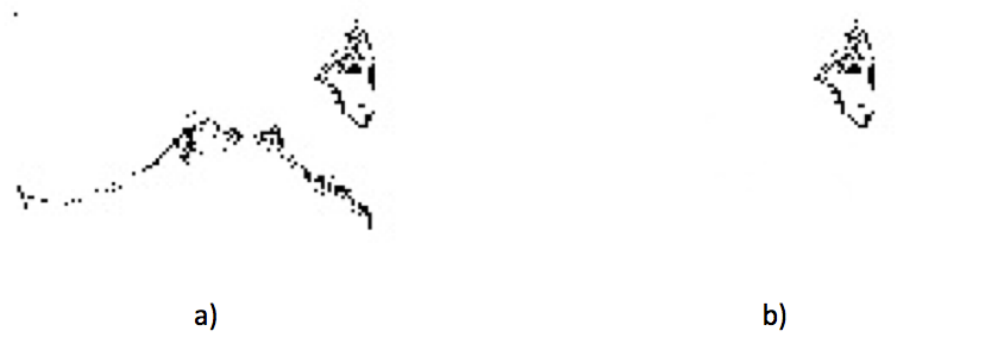
Figure 14. Angiogenesis detection example: ( a ) the hottest regions detected in a full thermogram; and ( b ) an isolated pattern indicating